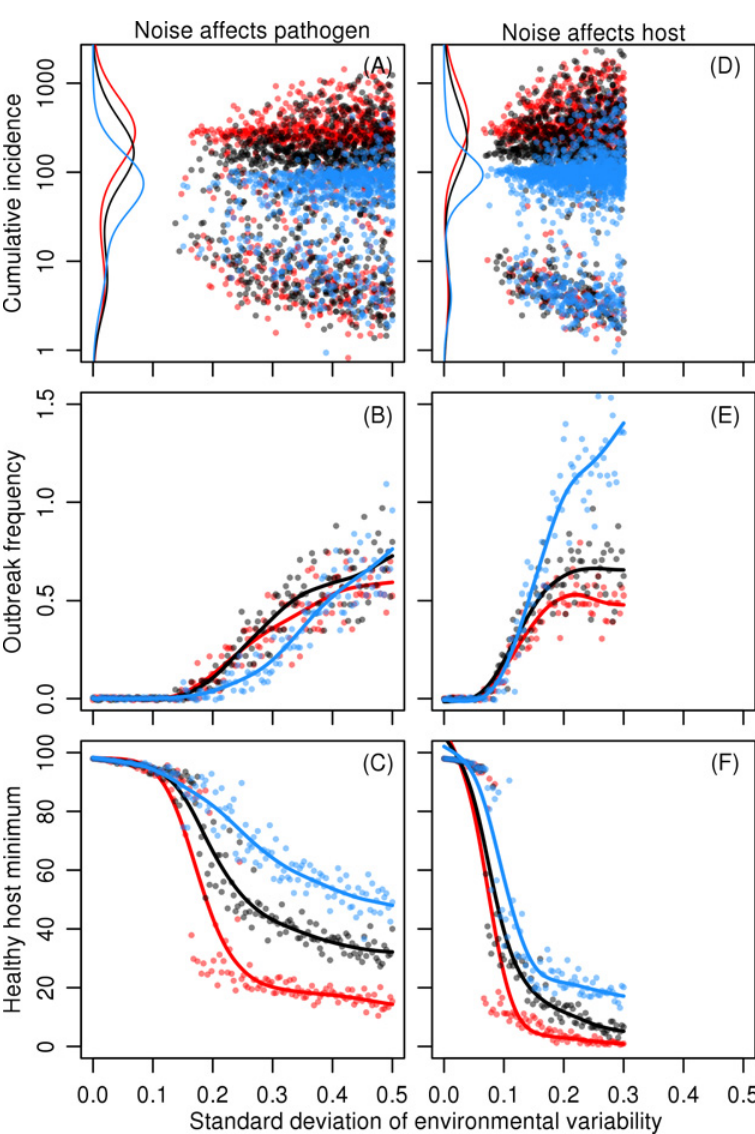
Fig 2. The effect of stochastic variation strength. The effect of pink stochastic variation on outbreak dynamics at different environmental variances. Left panels (A) – (C): variations affect pathogen growth rate r p . Right panels (D) – (F): variation affects 50% infective dose ID 50 . Top panels (A) and (D): cumulative incidences. Each dot represents a single outbreak, the number of which varies between simulations. The lines show a marginal kernel density estimate of peak areas. Panels (B), (C), (E) and (F): number of peaks and minimum values of healthy host density. Each dot represents a single simulation run. The lines show a smoothing spline fit to the points. In all simulations the spectral exponent γ = 1, i.e. pink noise. Colours red, black, and blue show results on rapid, intermediate, and slow immunity loss rates, respectively. See Table 1 for model